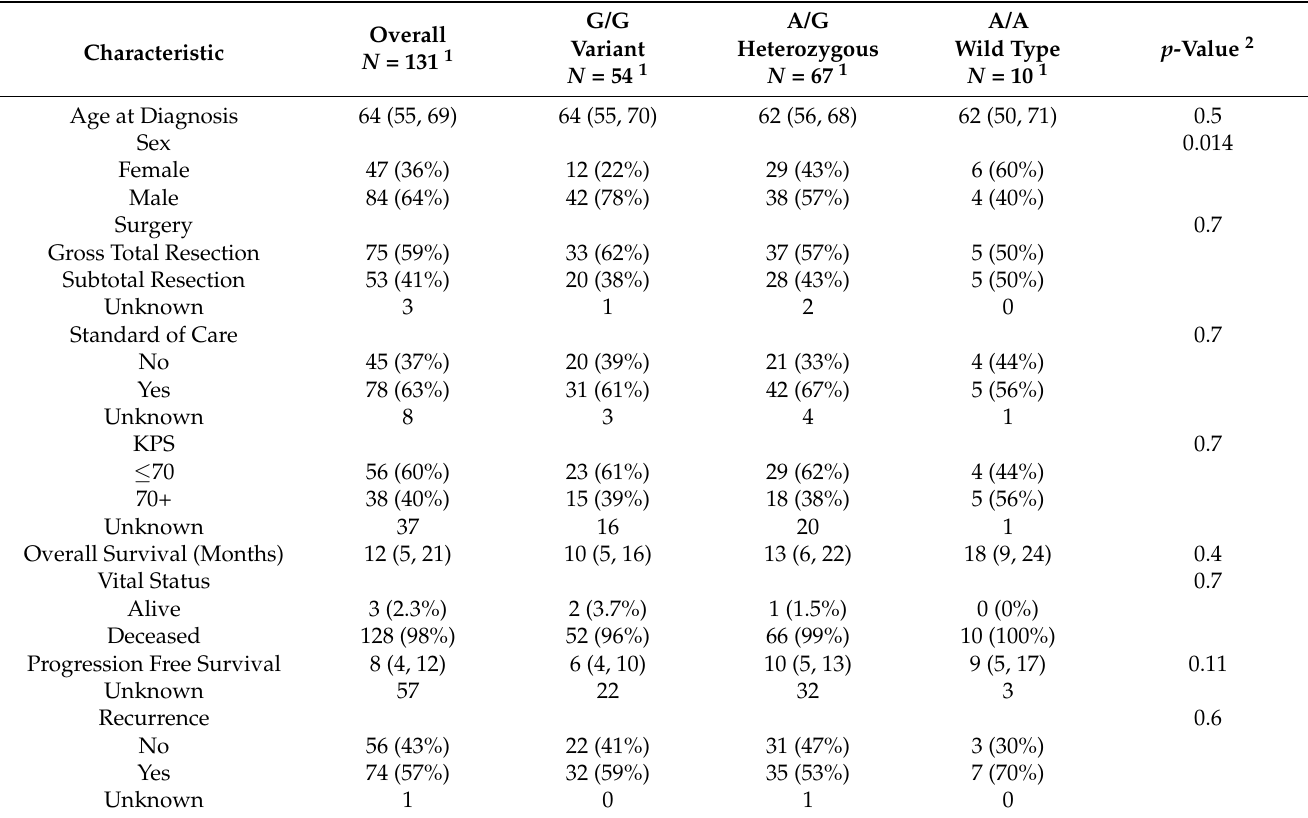
Table 2. Patient Characteristics by TSPO rs6971 polymorphism genotype from the CWRU dataset.